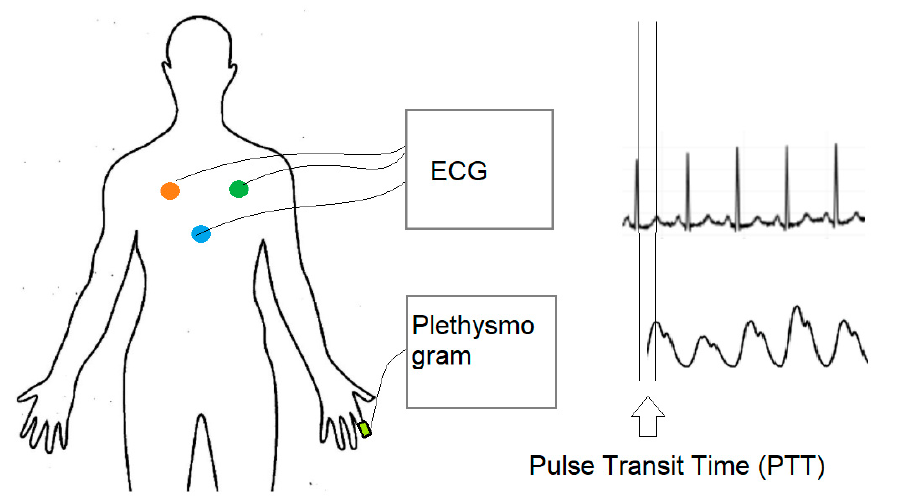
Figure 3. Pulse transit time (PTT).